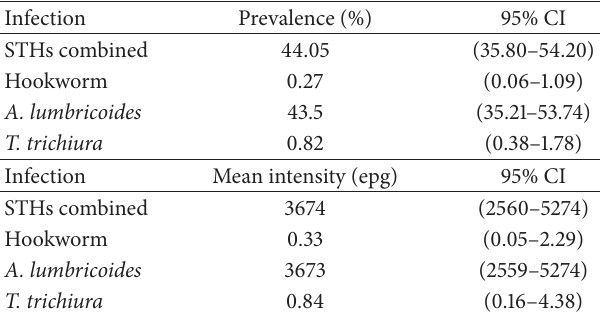
Figure 1: The age distribution of the children sampled for the study. Table 1: Overall prevalence and mean intensity of STH